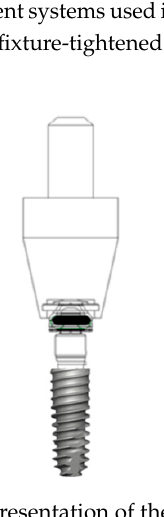
Figure 2. Schematic representation of the attachment systems.